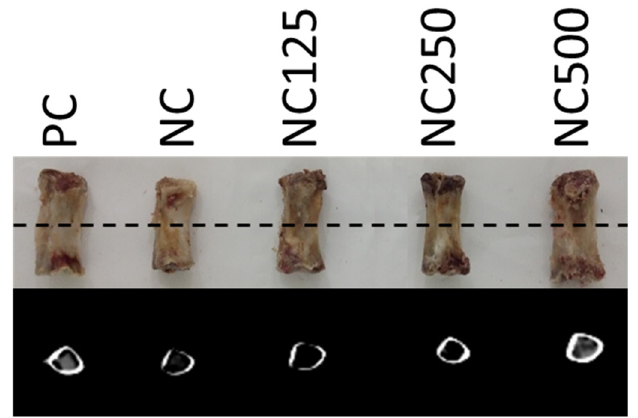
Figure 1. Example of disposition of the bones (one of each treatment) for the computed tomography (CT) acquisition and axial image obtained of the centre of the bones (discontinuous line).